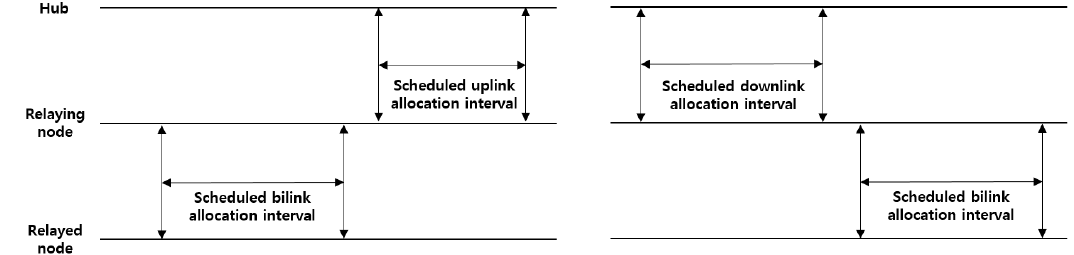
Figure 16. Two-hop scheduled allocations in MAP.